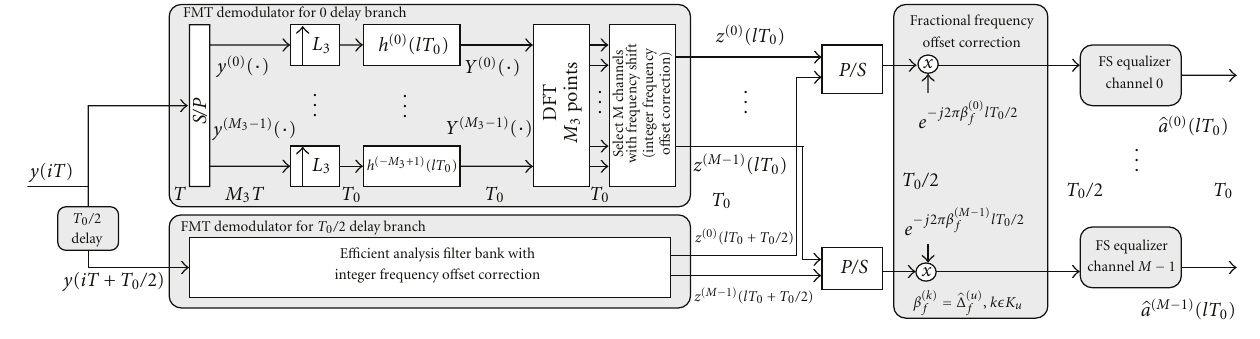
Figure 2: Multiuser analysis filter bank